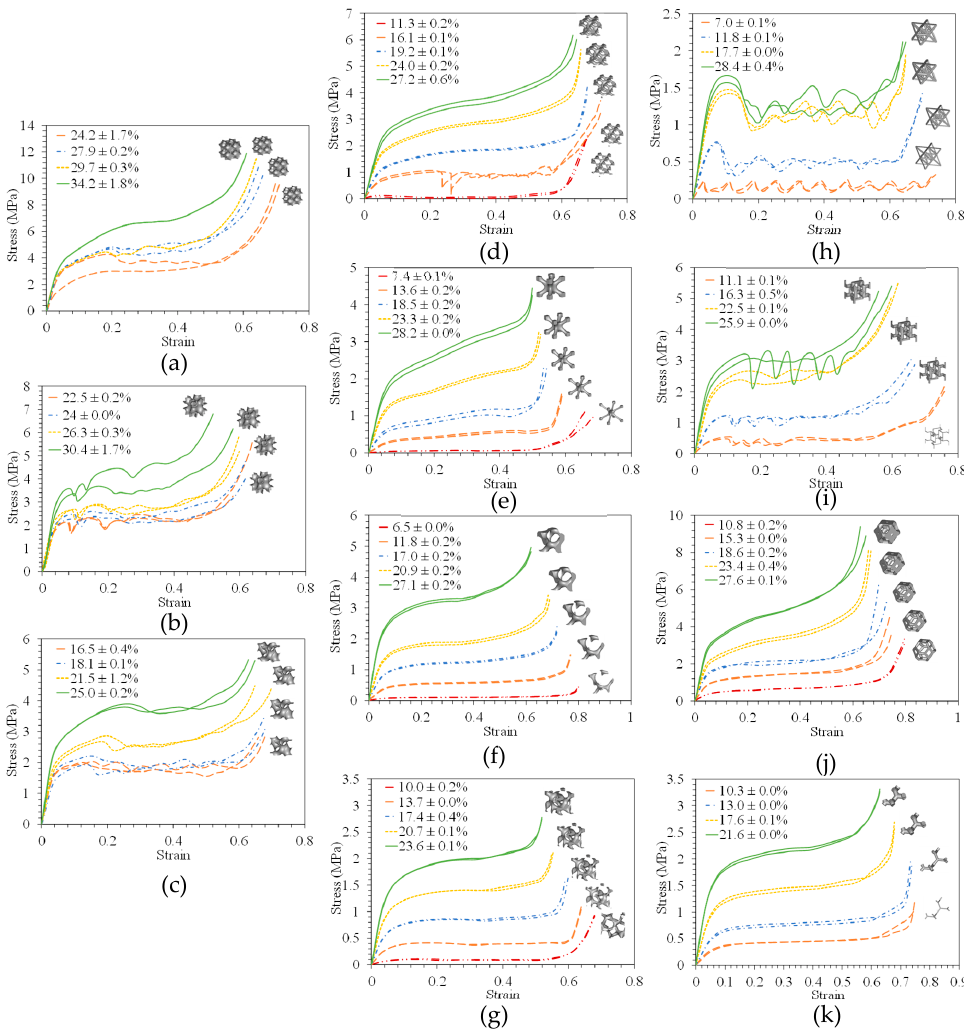
Figure 6. Stress–strain responses for the different lattice topologies of two replicates at various measured RDs: ( a ) D-STPMS, ( b ) IWP-STPMS, ( c ) G-STPMS, ( d ) D-LTPMS, ( e ) IWP-LTPMS, ( f ) G- LTPMS, ( g ) CY-LTPMS, ( h ) Octet-Truss, ( i ) Gibson–Ashby, ( j ) Kelvin, and ( k ) Idealized Gyroid. All samples are compressed at a strain rate of 0.001/𝑠 .